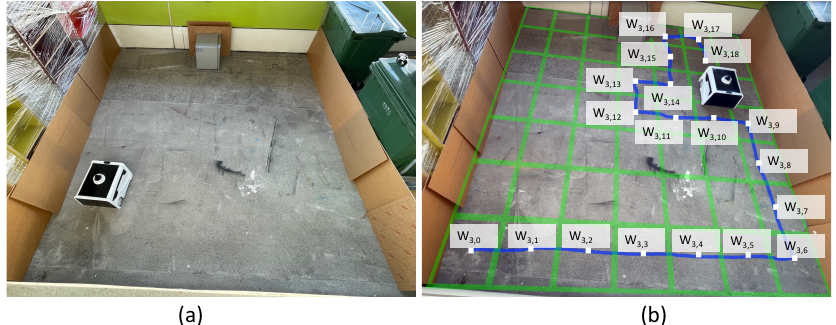
Figure 10. The environment setup for trial-3 ( a ), and the approximate path traversed and locations visited by the robot ( b ).